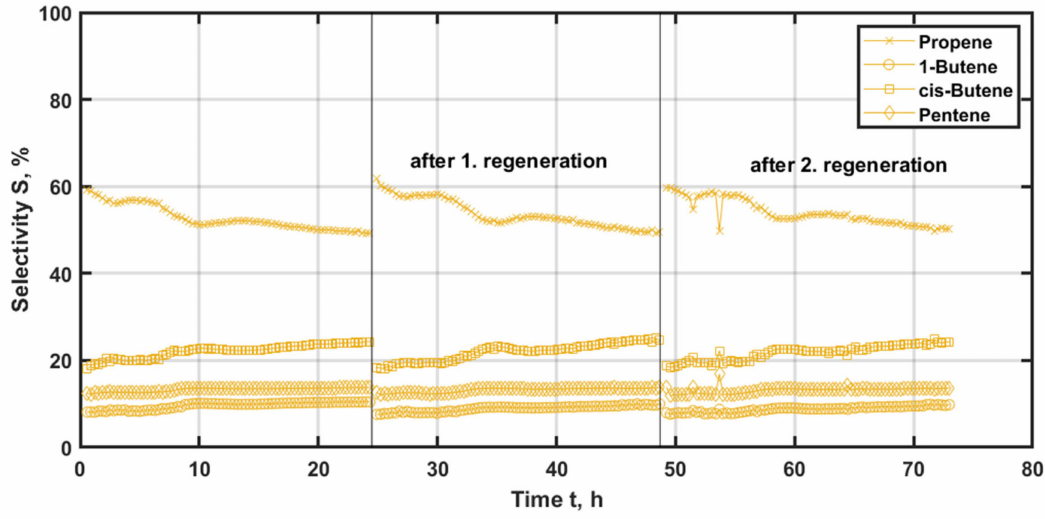
Figure 9. Selectivity of the main reaction products with time-on-stream (TOS) applying Re/AlMCM-41(60) as the catalyst at 200 ◦ C and 500 kg cat · s · m − 3 , with regeneration at 500 ◦ C and 20% oxygen for 3